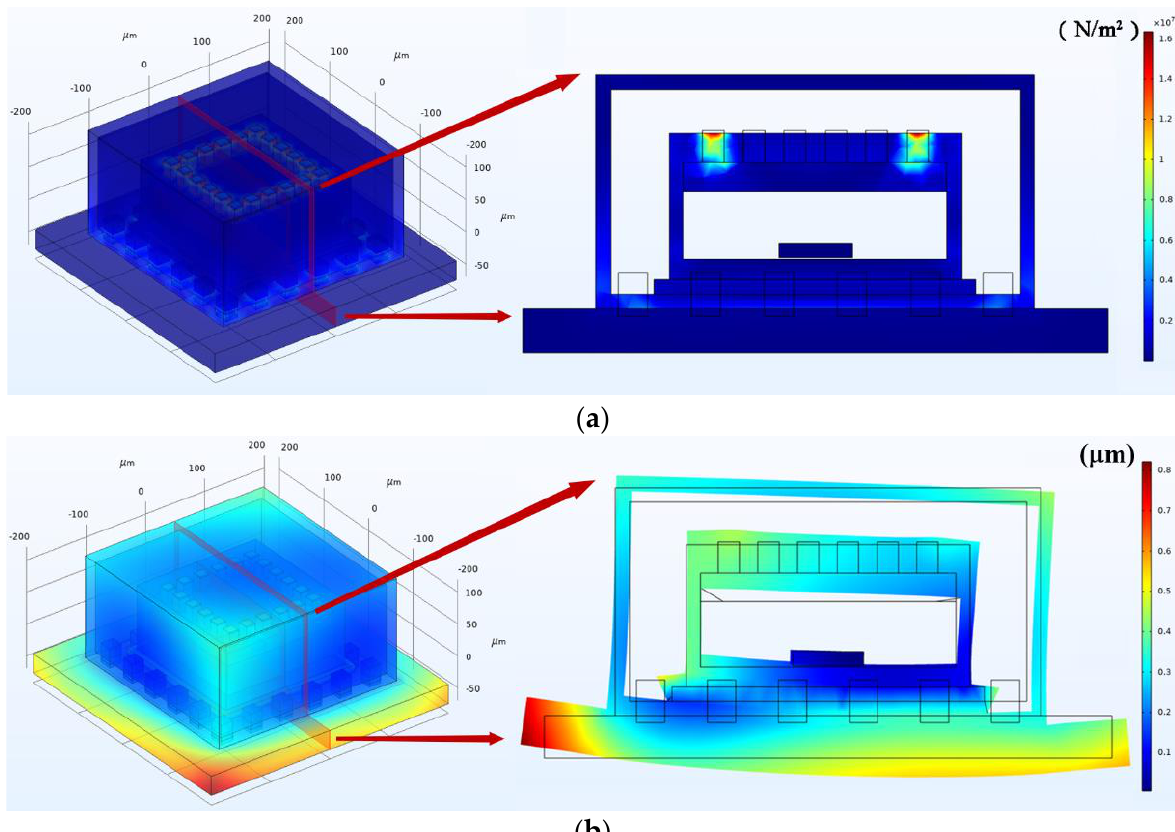
Figure 10. The ( a ) stress and ( b ) displacement distribution within TFGs at temperature equilibrium stage.